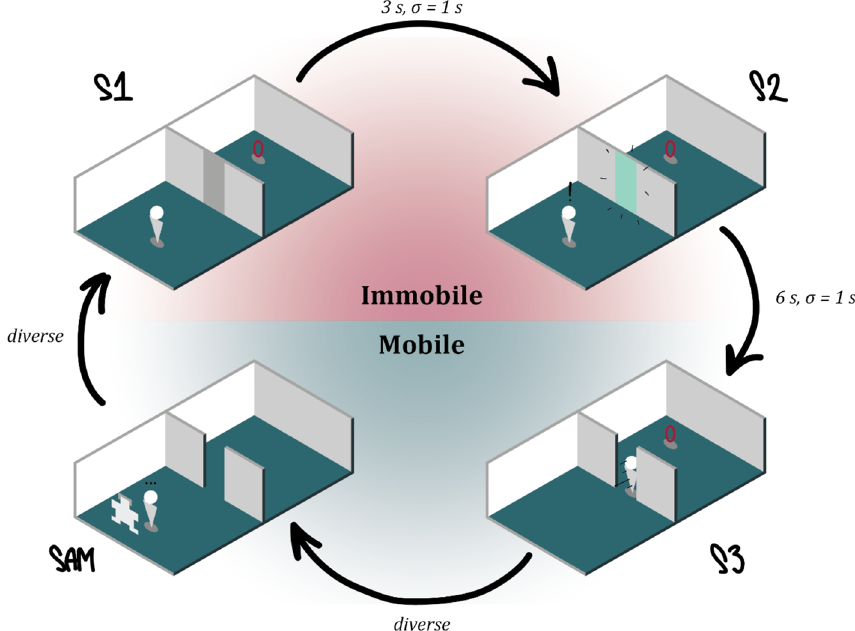
Figure 1. The experiment started as depicted in the top-left diagram. Participants were instructed to wait for the lights to come on as they were waiting in the dark (3 s, σ = 1 s). Once the lights came on (S1) they perceived the door they had to pass, however, they were instructed to wait (6 s, σ = 1 s) for the colour of the door to change. Once the colour changed (S2), it turned either green (Go) or red (NoGo). In the case of Go, participants passed the opening (S3), virtually touched the red circle (which in turn releases a monetary bonus), returned to the starting position, and completed the virtual SAM questionnaire. In the case of NoGo, participants turned around and completed the virtual SAM questionnaire. The three different doors had the following dimensions: Narrow, 0.2 m; Mid, 1 m; Wide, 1.5 m. Note the colour codes for each the immobile and mobile phases as they are used throughout the